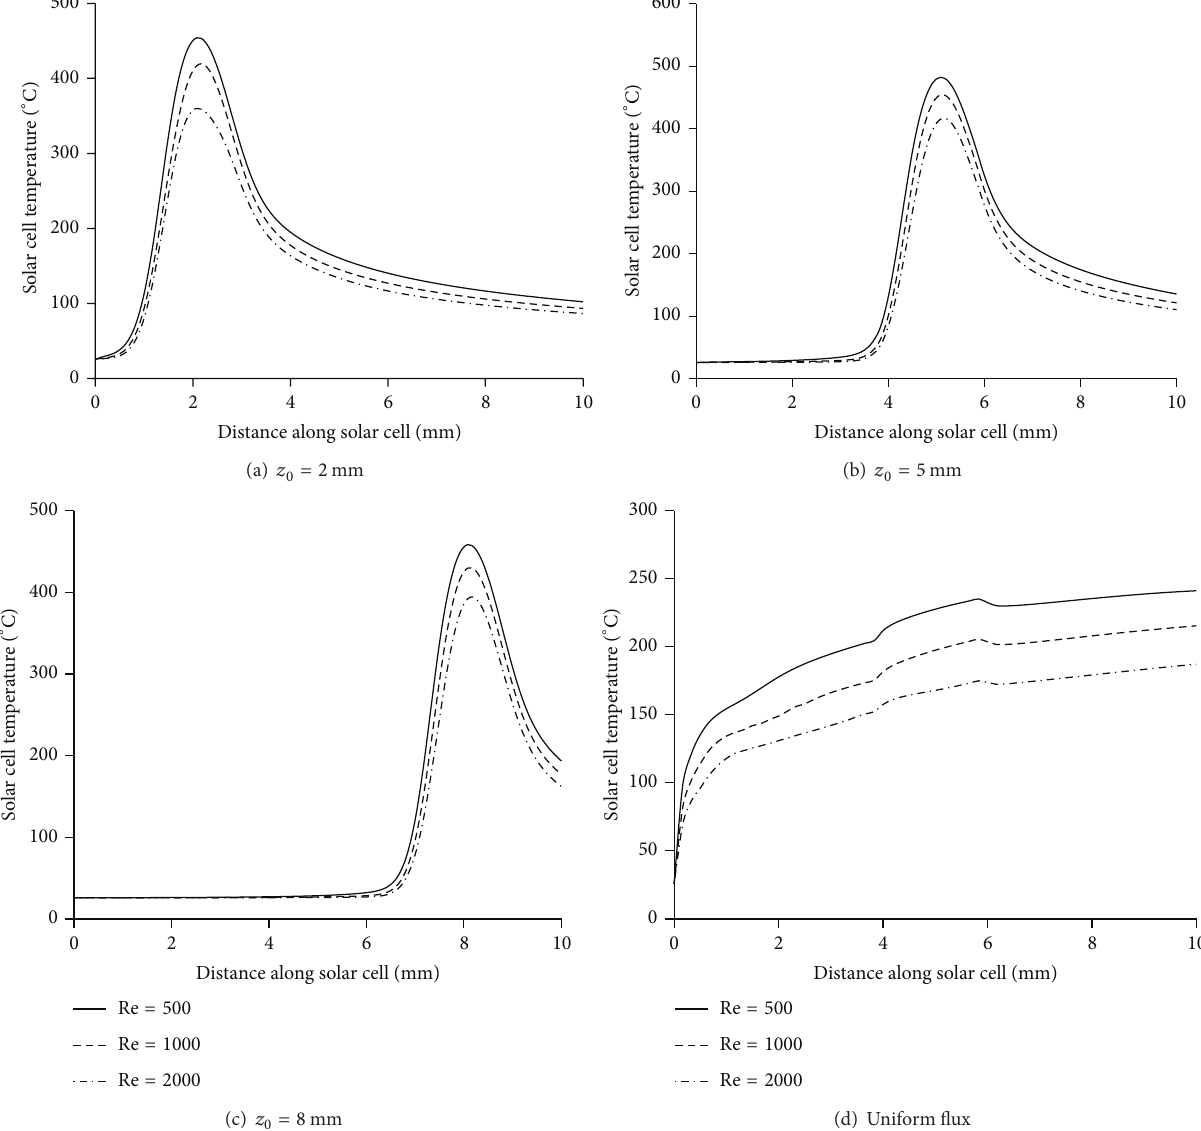
For 𝑍 > 0 and 𝑌 = 𝑌 𝑠